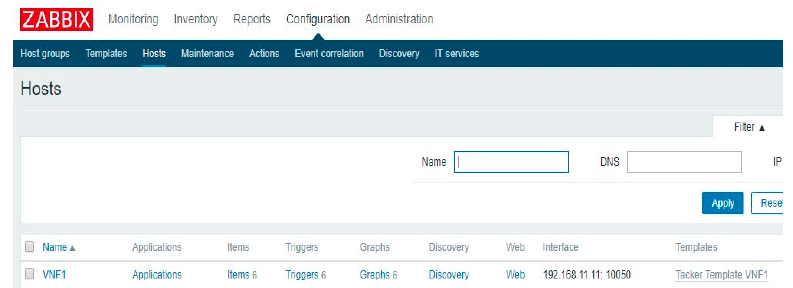
Figure 9. VNF registration on the monitoring server.